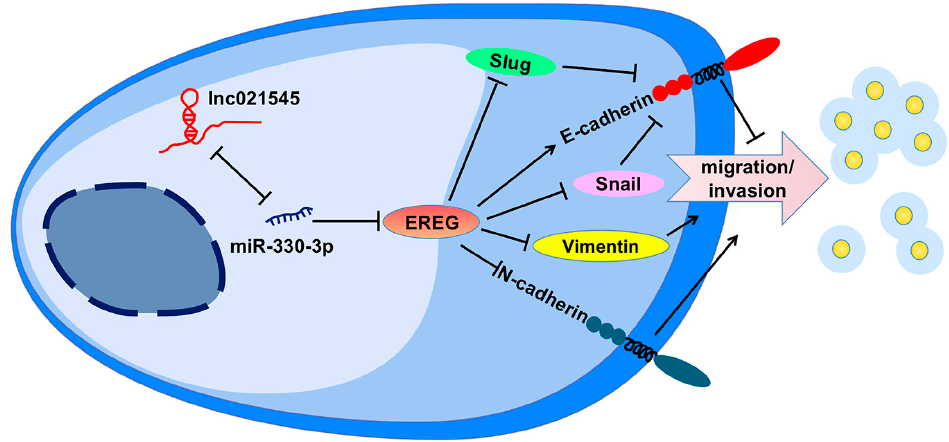
Figure 9. A schematic action mechanism of the lnc021545-miR-330-3p-EREG axis in the BC’